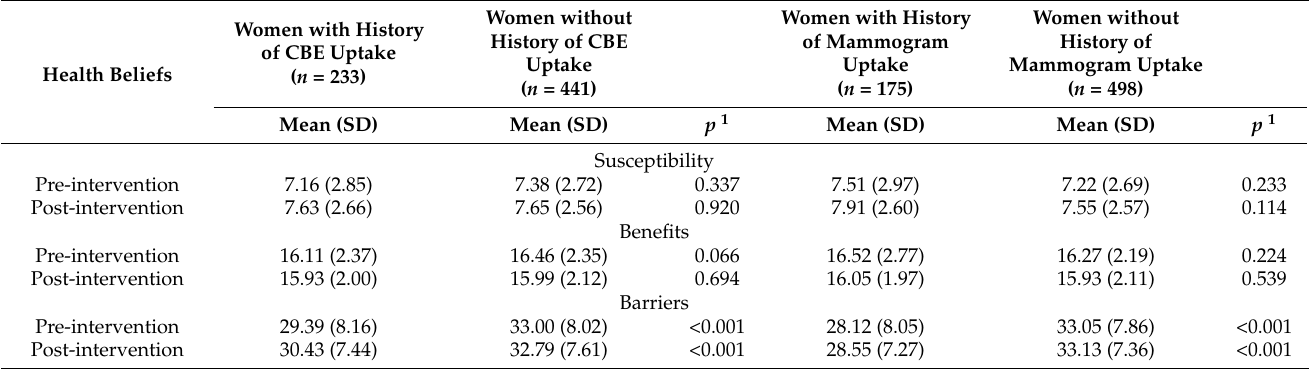
Table 3. Women’s health beliefs in relation to the past history of screening uptake ( n = 676). Women with History of CBE Health Beliefs